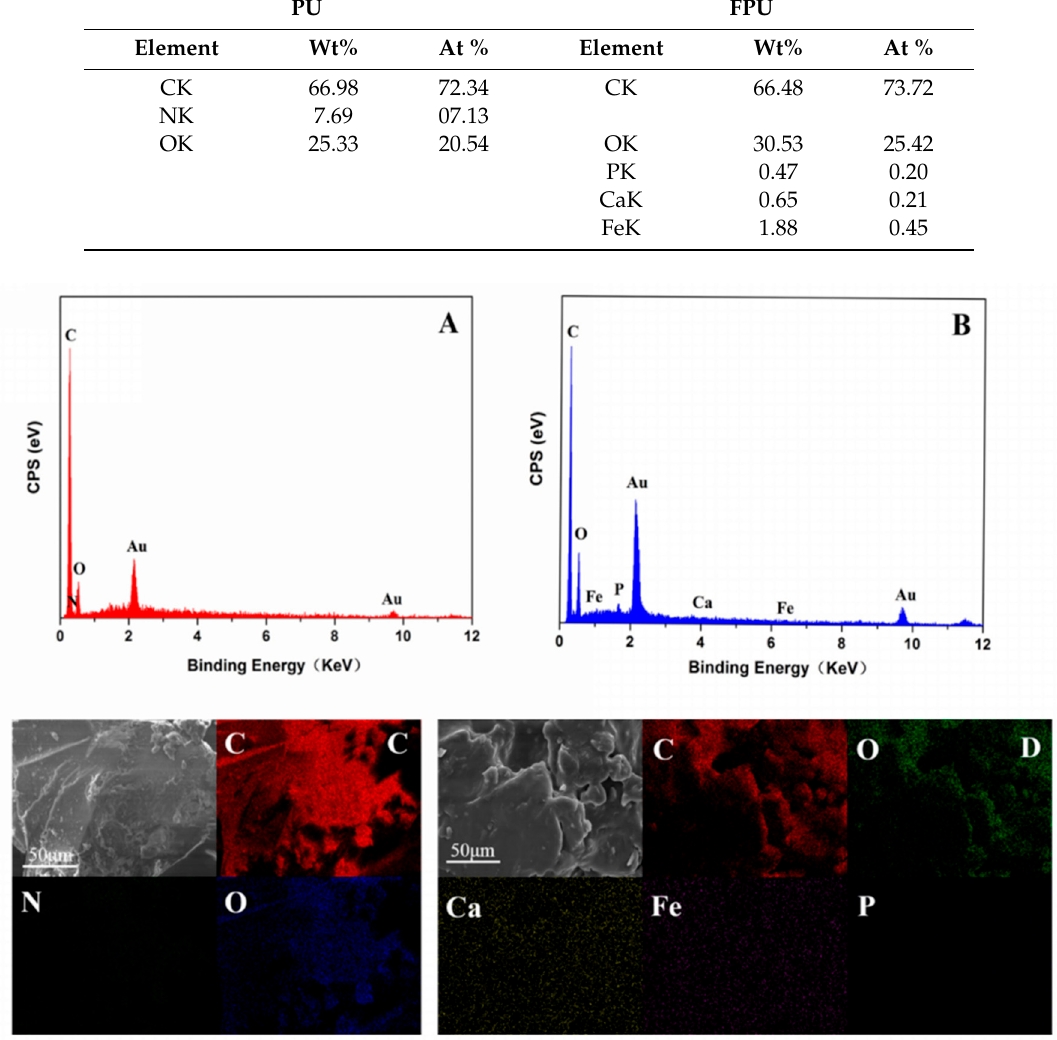
Figure 3. ( A , B ) EDX spectra and ( C , D ) EDX maps corresponding to the SEM images for surface elemental compositions and distributions of PU and FPU coatings.